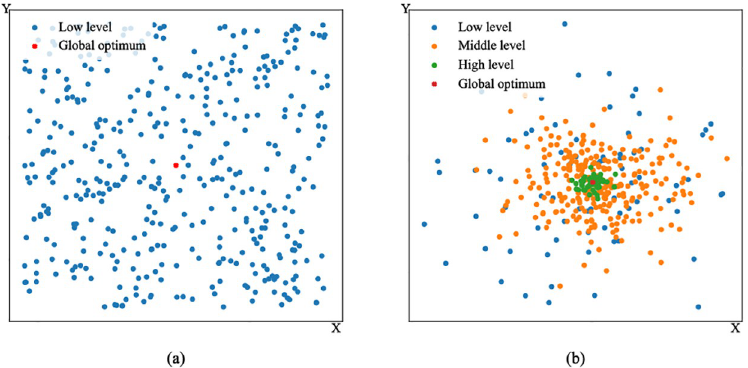
Fig 1. Variations of particles’ levels during the iterations in two-dimensional unimodal problems. The points represent the particles. (a) The early stage. (b) The latter stage.